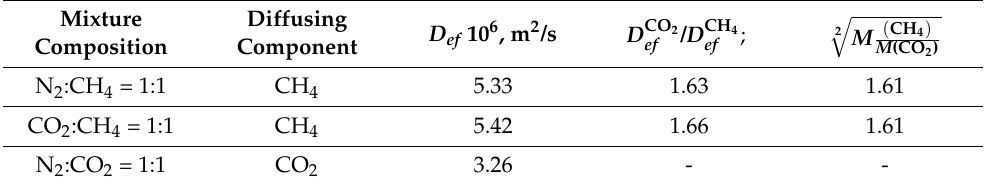
Table 3. Effective diffusion coefficients of methane and carbon dioxide, established experimentally under isothermal conditions (at a temperature of 200 ◦ C by the diaphragm